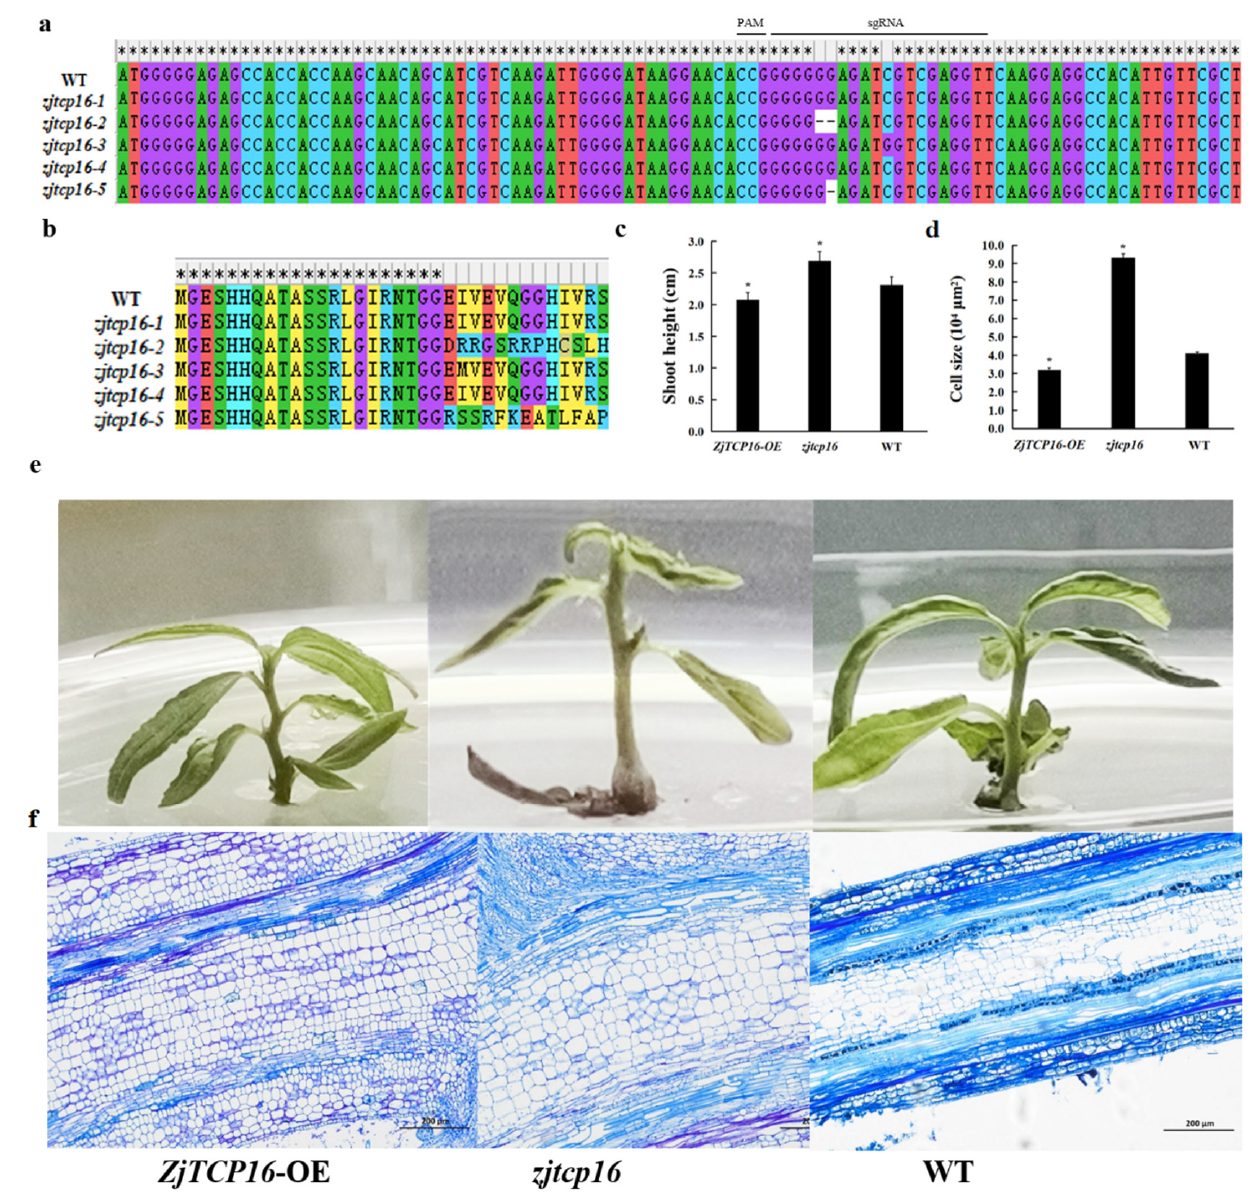
Figure 5. ( a ): DNA sequencing of the target locus in the zjtcp16 CRISPR mutant compared to WT. The alignment shows the single-guide RNA (sgRNA) binding sites including the corresponding protospacer-adjacent motif (PAM). Matching nucleotide residues at the same position are represented by the same color. ( b ): Protein sequence aligns between the target locus in the zjtcp16 CRISPR mutants and WT. ( c ): Average height of ZjTCP16-OE jujube lines, zjtcp16 mutant lines and WT. Bar = 1 cm. ( d ): Size of 50 cells in ZjTCP16-OE, zjtcp16 lines and WT. ( e ): Phenotype of ZjTCP16-OE jujube lines, zjtcp16 mutant lines and WT at 1 month; ( f ): Observation on the stem and cell section of the internode in ZjTCP16-OE jujube lines, zjtcp16 mutant lines and WT. Bar = 200 µ m. (*: p <